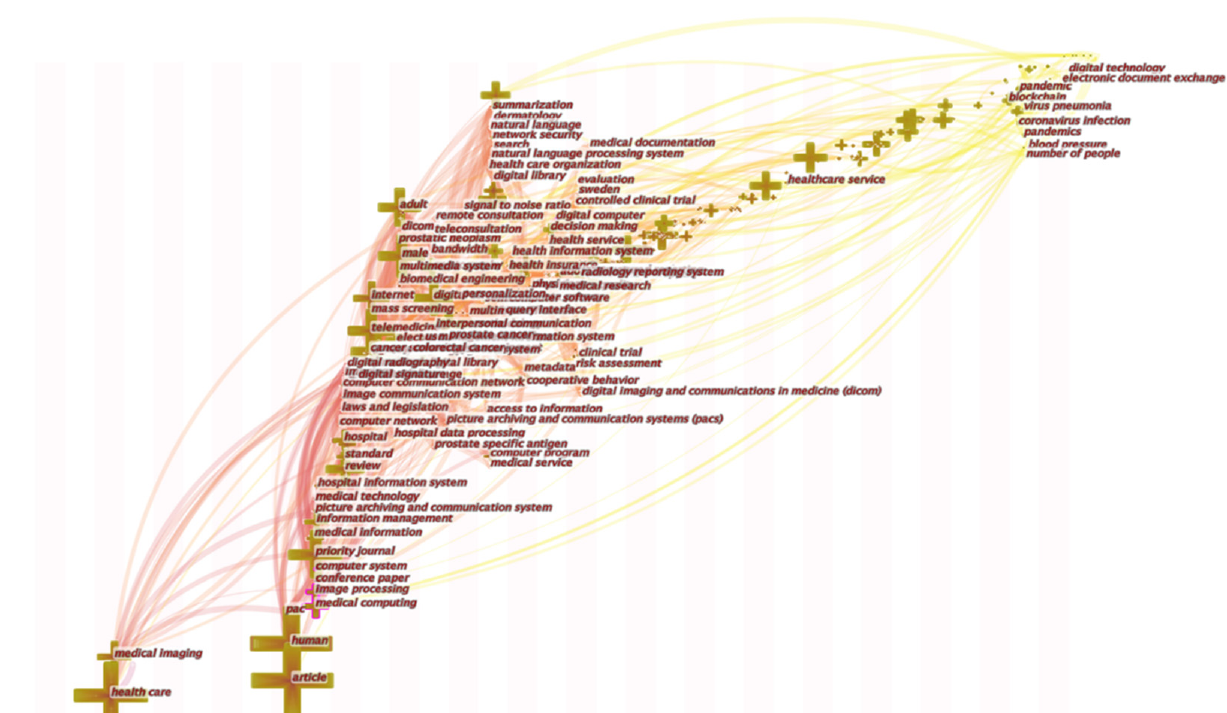
Figure 9. Keyword evolution map on digital healthcare. Table 4. The top nine medical service stocks in the U.S. for gains in 2020. Securities